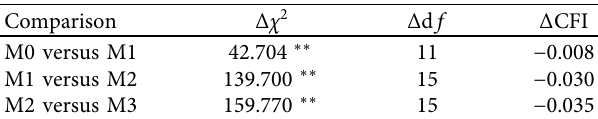
Table 13: Model comparisons for multisample structural equation models (LK versus